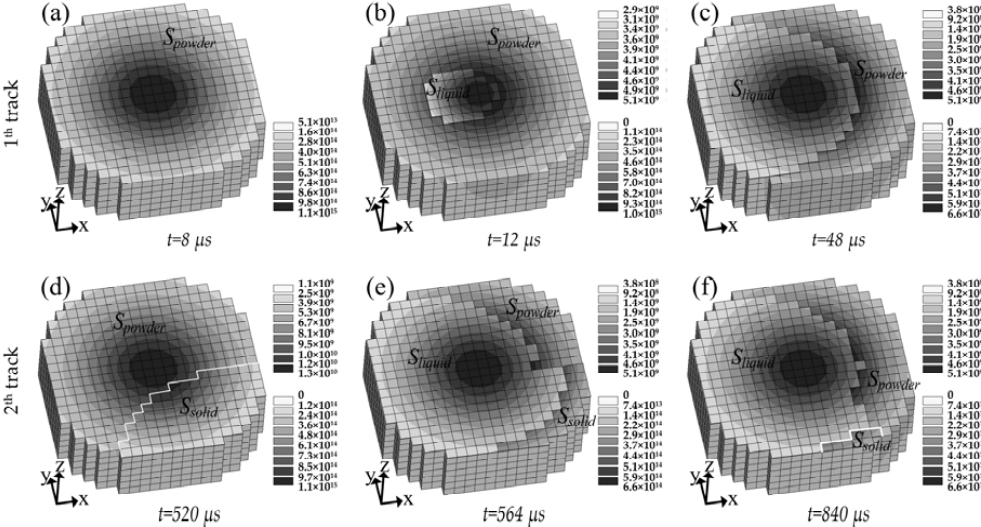
Figure 8. Area distribution of the powder, solid, and liquid state material and their absorbed energy density distribution at laser spot location at various times and tracks of Figure 7. The top right legend corresponds to the material in the dense state (unit in J m − 2 s − 1 ), while the bottom right legend corresponds to the material in the powder state (unit in J m − 3 s − 1 ).